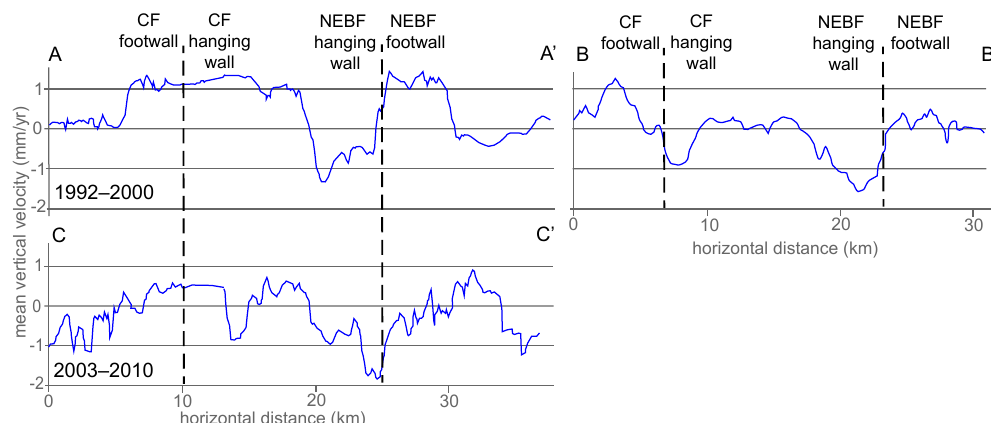
Figure 13. Postseismic ground deformation profiles across the 1980 Irpinia earthquake epicentral area (see Figure 12a for locations of profiles A–A’ and B–B’ and Figure 12b for location of profile C–C’). The dashed black lines indicate the locations of the projections at the surface of the deep-seated CF and NEBF, which correspond to the structures activated with the 1980 Irpinia earthquake at 0 s and 40 s,